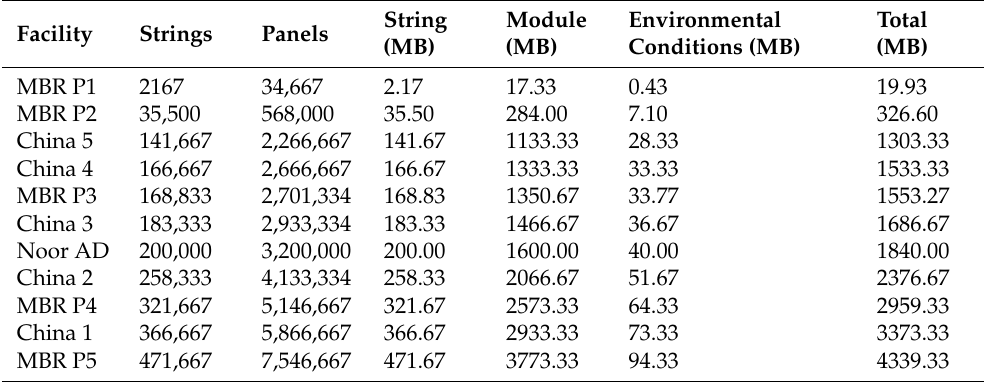
Table 4. Breakdown of amount of estimated data per reporting period transmitted per category for